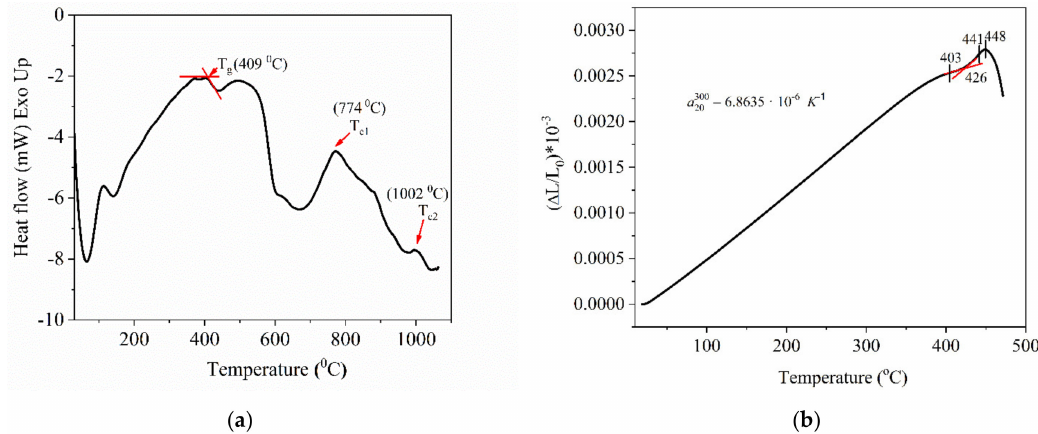
Figure 5. ( a ) Di ff erential Scanning Calorimetry (DSC) thermal scan of the Te-5 glass sample and ( b ) the dilatometric thermal expansion plot of the Te-5 glass.